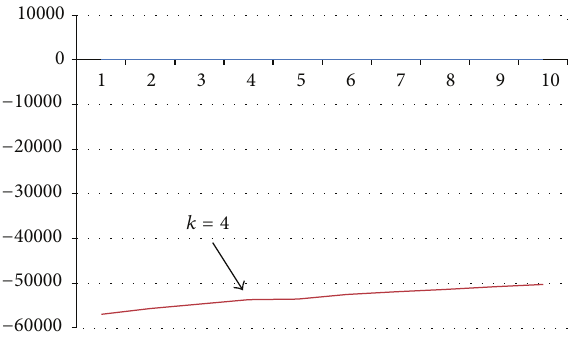
Figure 1: STRUCTURE results using 110 loci. Log probability data [LnP (𝐷) ] as function of 𝑘 (number of groups) from the STRUCTURE run. The plateau of the graph at 𝑘 = 4 indicates the minimum number of groups (subpopulations) possible in the panel.